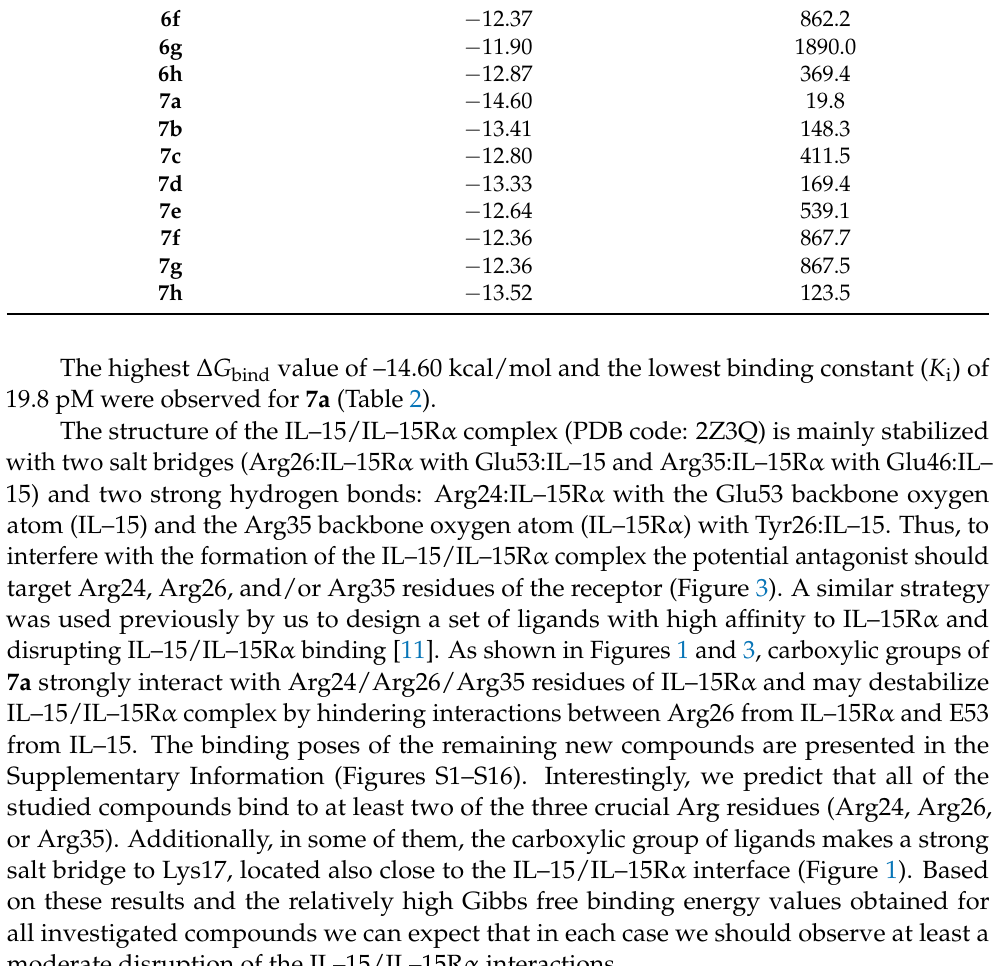
Table 2. Free energy of binding ( ∆ G bind ) and binding constant ( K i ) estimated for the evaluated compounds. Molecule ∆ G bind [kcal/mol] K i [pM] 6a − 13.31 175.3 6b − 13.75 83.1 6c − 13.73 85.6 6d − 12.38 848.7 6e − 12.24 1070.0 6f − 12.37 862.2 6g − 11.90 1890.0 6h −